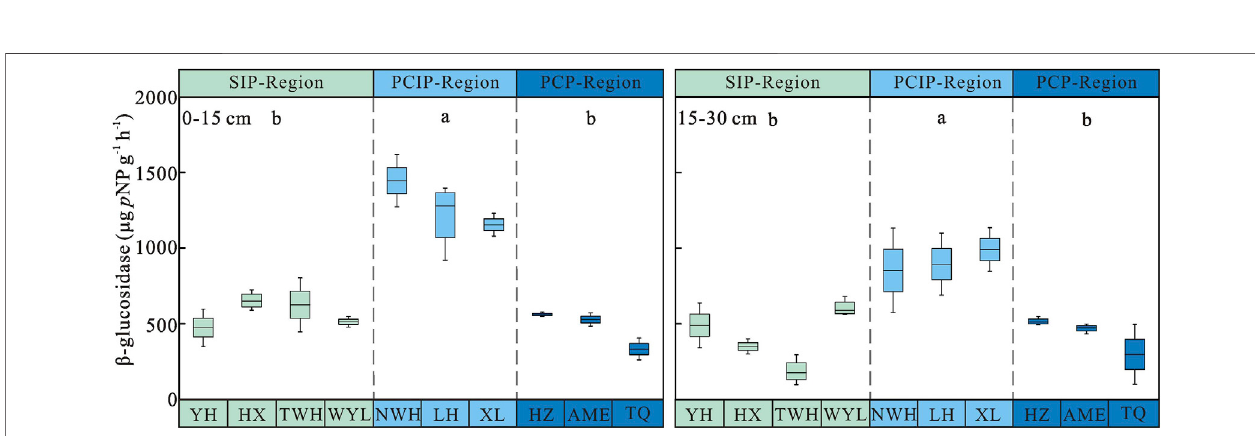
Frontiers in Environmental Science |